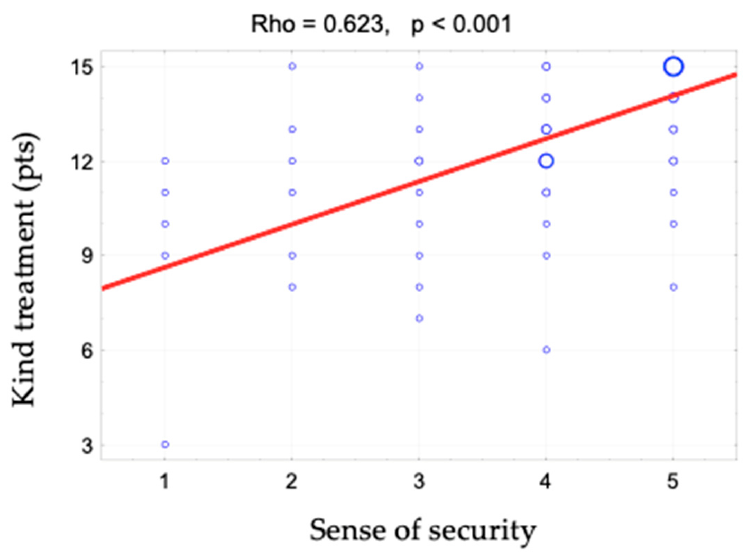
Figure 3. Correlation diagram between the sense of security (1—definitely not, 2—rather not, 3— partially, 4—rather yes, 5—definitely yes) and kindness and the value of Spearman’s rank correlation coefficient (rho) .